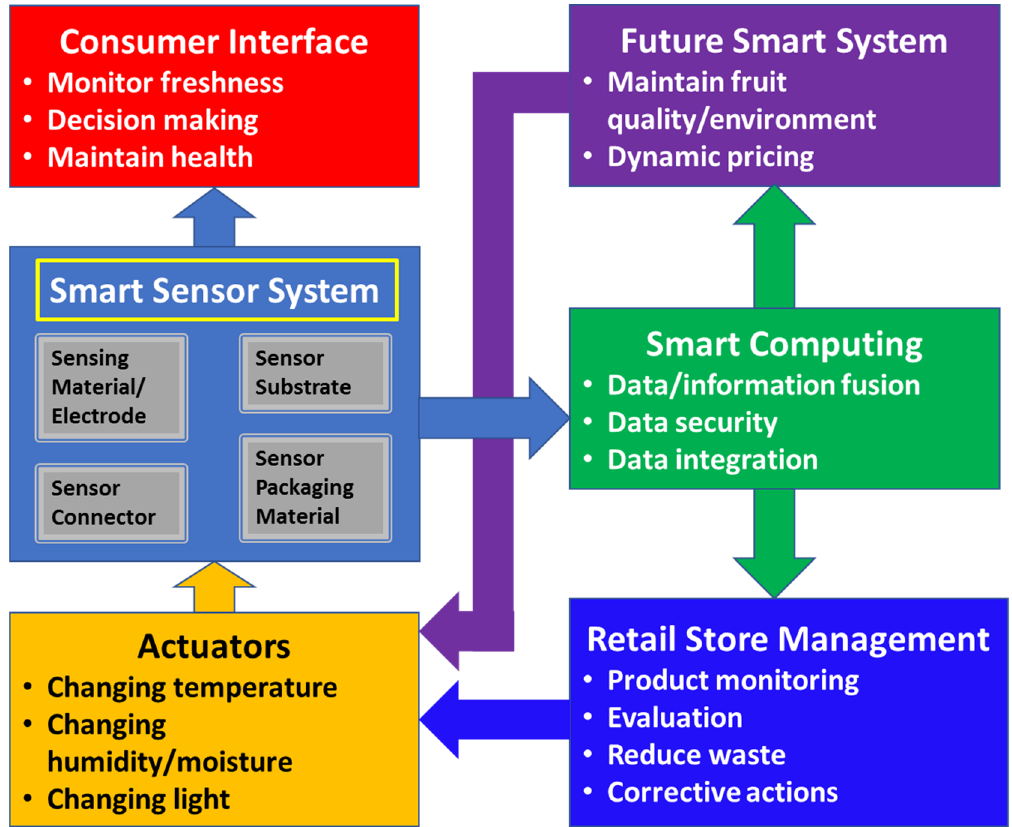
Figure 13. Schematic diagram illustrating how Smart Sensor Systems can be integrated with smart computing, and consumer and retailer needs for monitoring fruit quality, reducing waste, and improving consumer well-being.